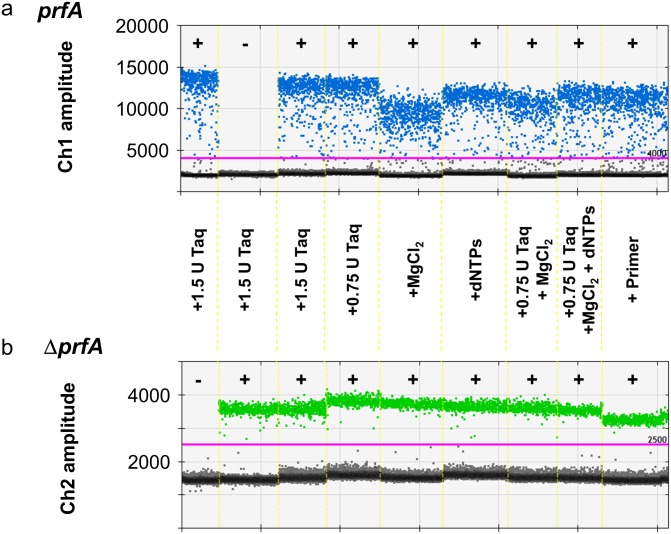
Droplet pattern with increased concentrations of polymerase, primers, dNTPs and MgCl2.ddPCR was performed with EGDe DNA (≈ 103copies/sample, Ch1 (+)) and ΔprfA DNA (≈ 103 copies/sample, Ch2 (+)) using modifications of the components Taq polymerase (+1.5 U, +0.75 U), MgCl2 (+25 nmol), dNTPs (+2.5 nmol each), Taq polymerase (+0.75 U) with MgCl2 (+12.5 nmol), Taq polymerase (+0.75 U) with MgCl2 (+12.5 nmol) and dNTPs (+2.5 nmol each) as well as increased primer concentrations (937.5 nM final concentration).